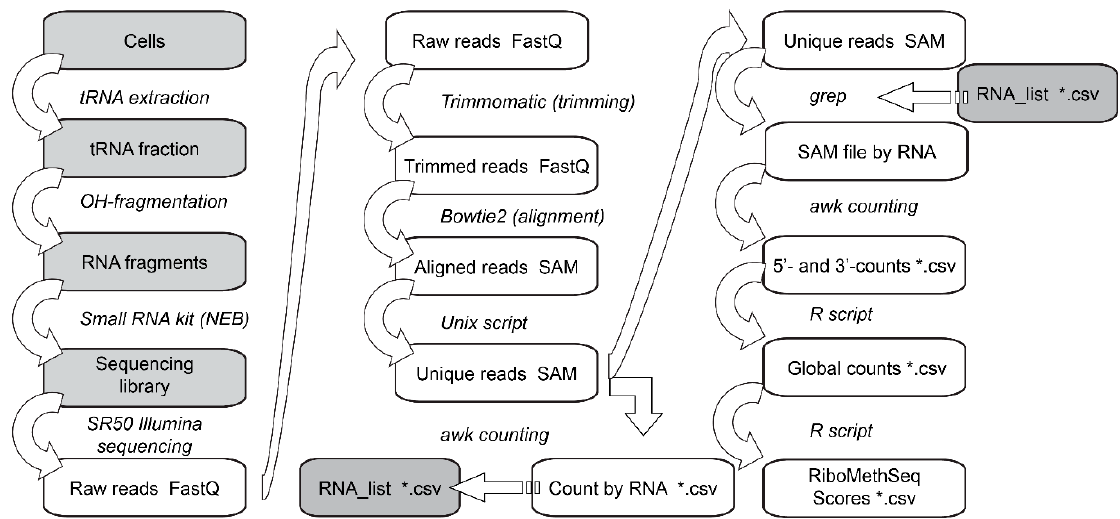
Figure 3. Optimized treatment pipeline for tRNA 2 ′ ‐ O ‐ methylation analysis by high ‐ throughput sequencing. SAM: sequence alignment/map.